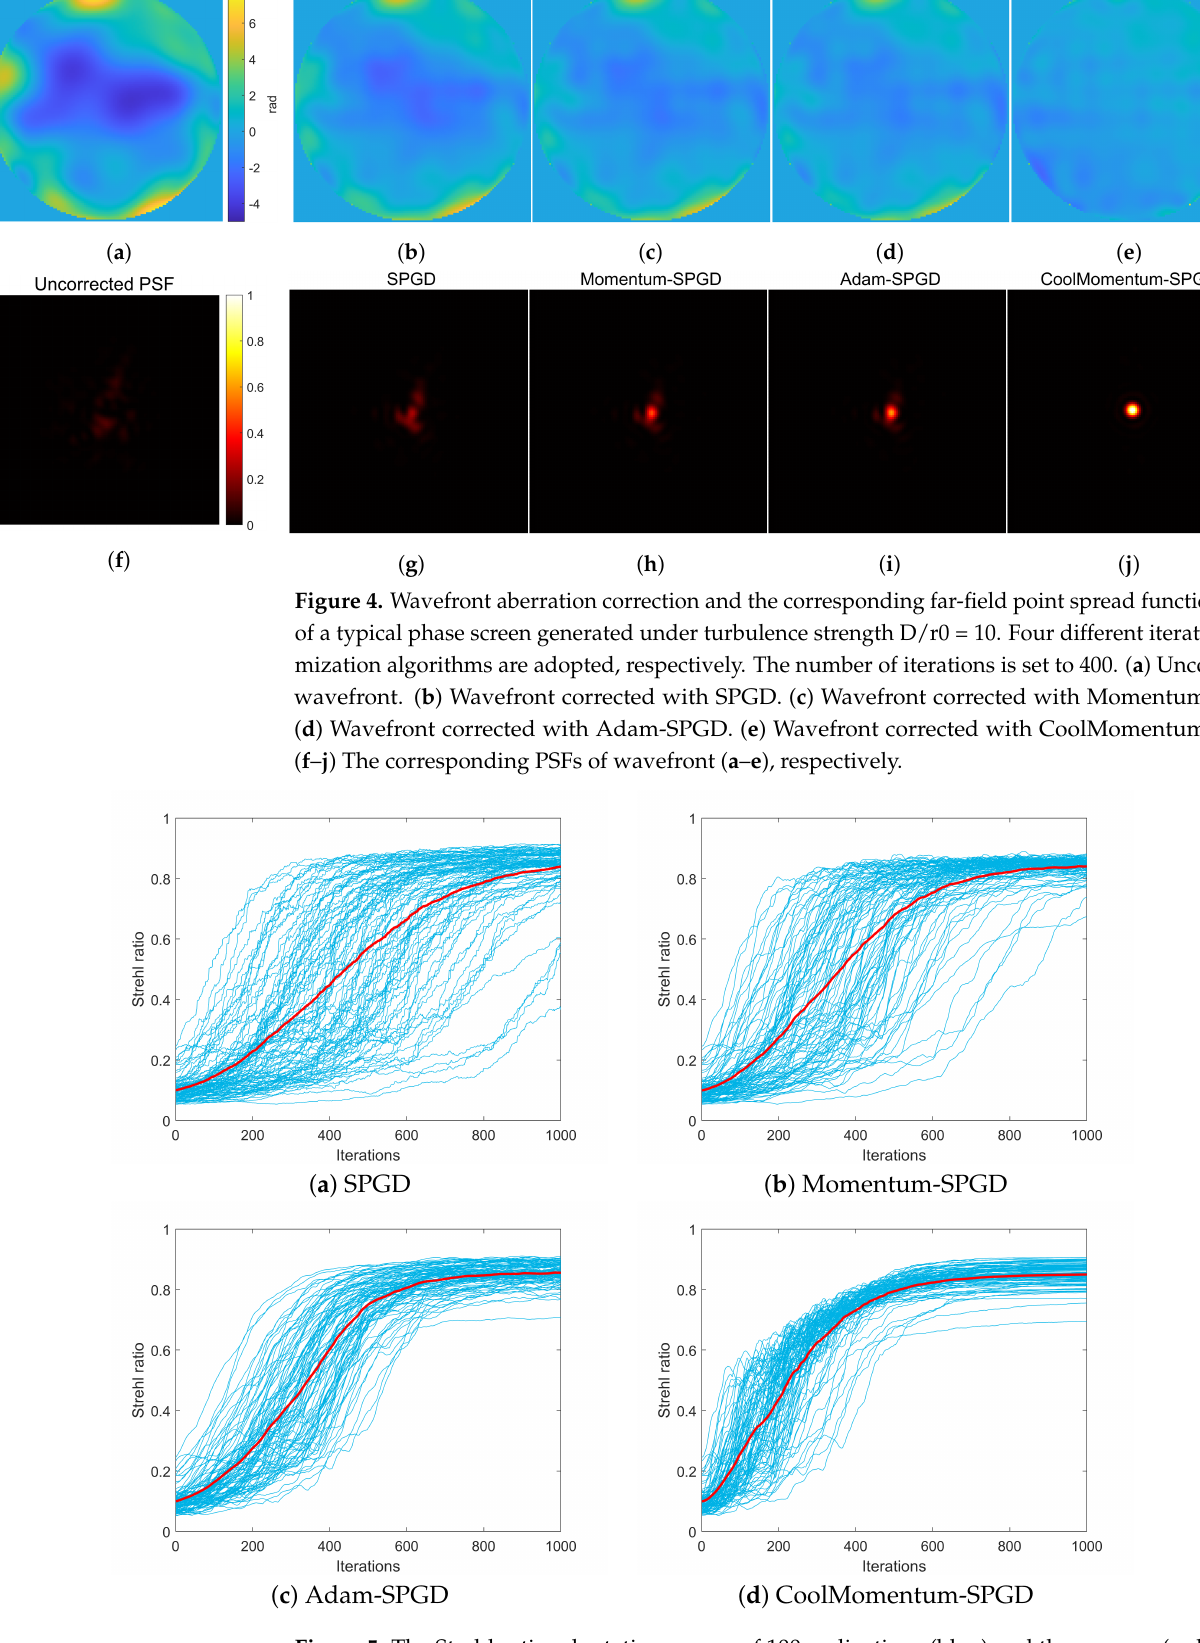
Figure 5. The Strehl ratio adaptation curves of 100 realizations (blue) and the average (red) under turbulence strength D/r0 =